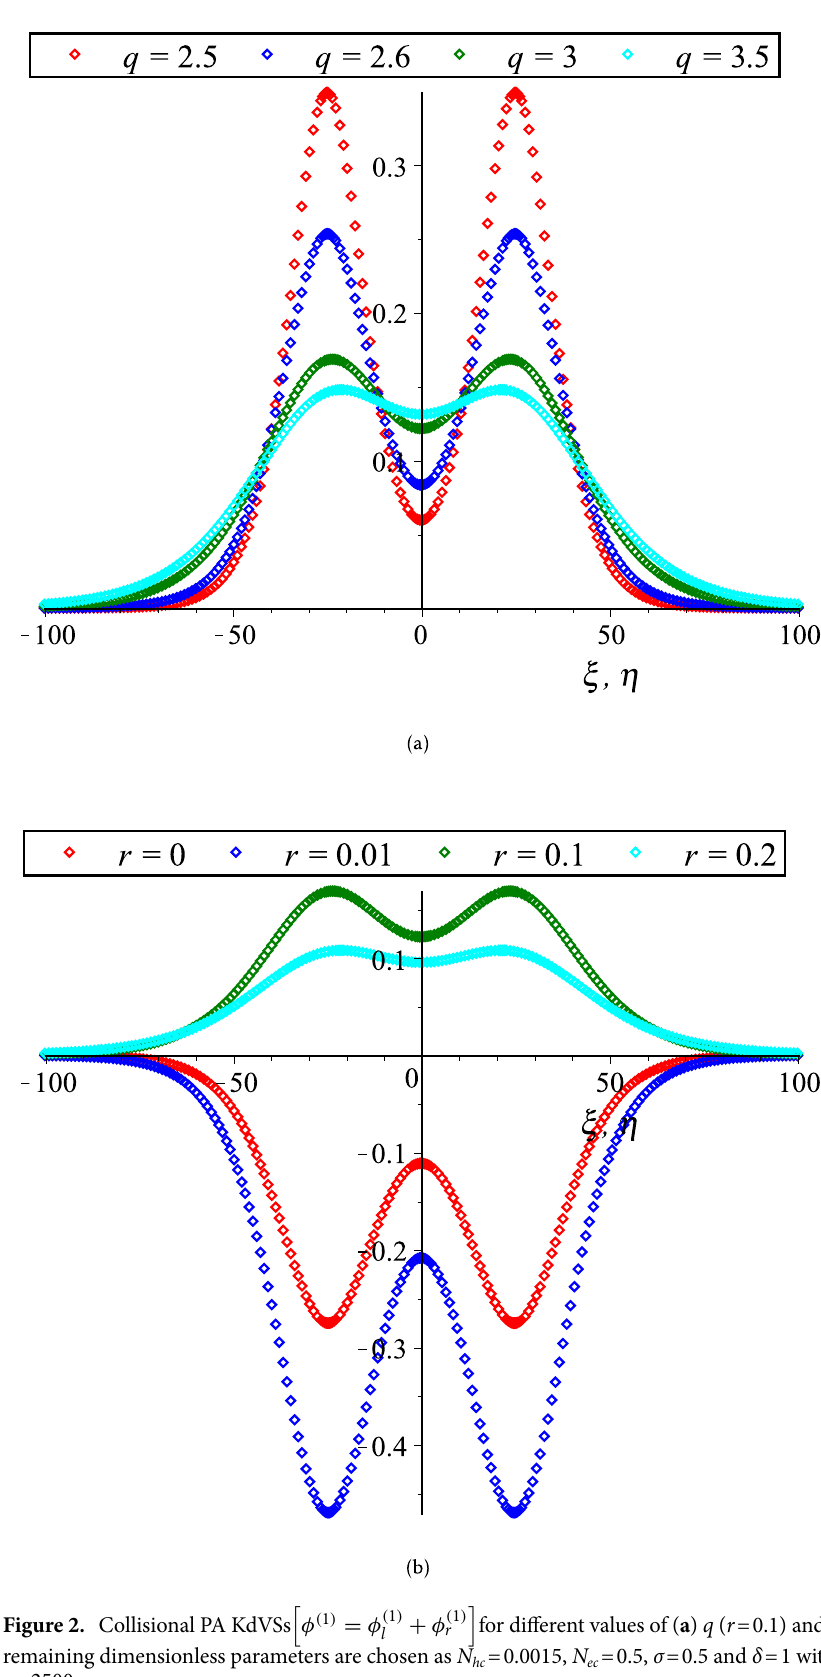
Figure 2. Collisional PA KdVSs remaining dimensionless parameters are chosen as N hc = 0.0015, N ec = 0.5, σ = 0.5 and δ = 1 with U 0 = 0.01 and τ =